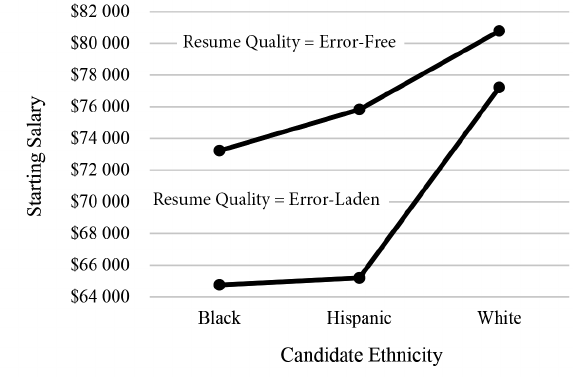
Figure 1. Starting salary of job applicants by candidate ethnicity and resume